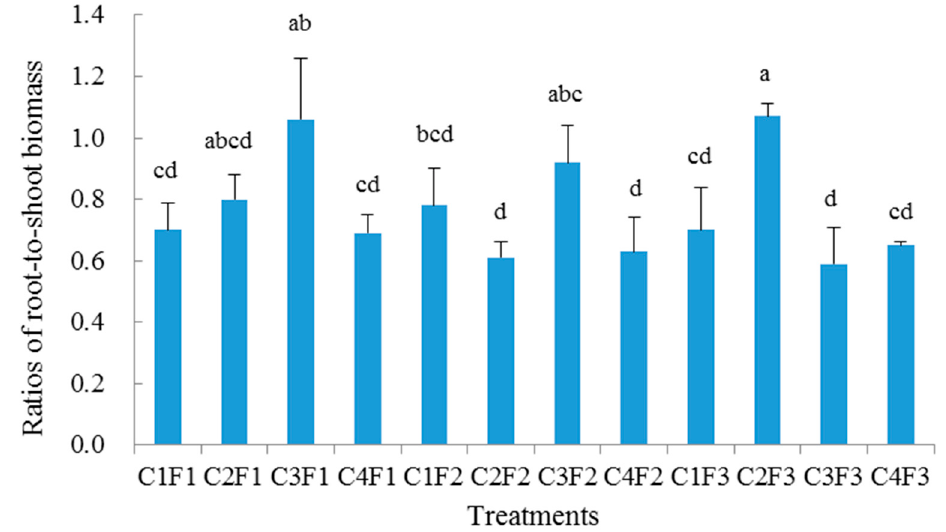
Figure 2. The integrated effect of treatments on the shoot-to-root biomass ratio of Cyclocarya paliurus seedlings (means ± standard deviation). The means followed by different letters are statistically different ( p < 0.05, LSD test).